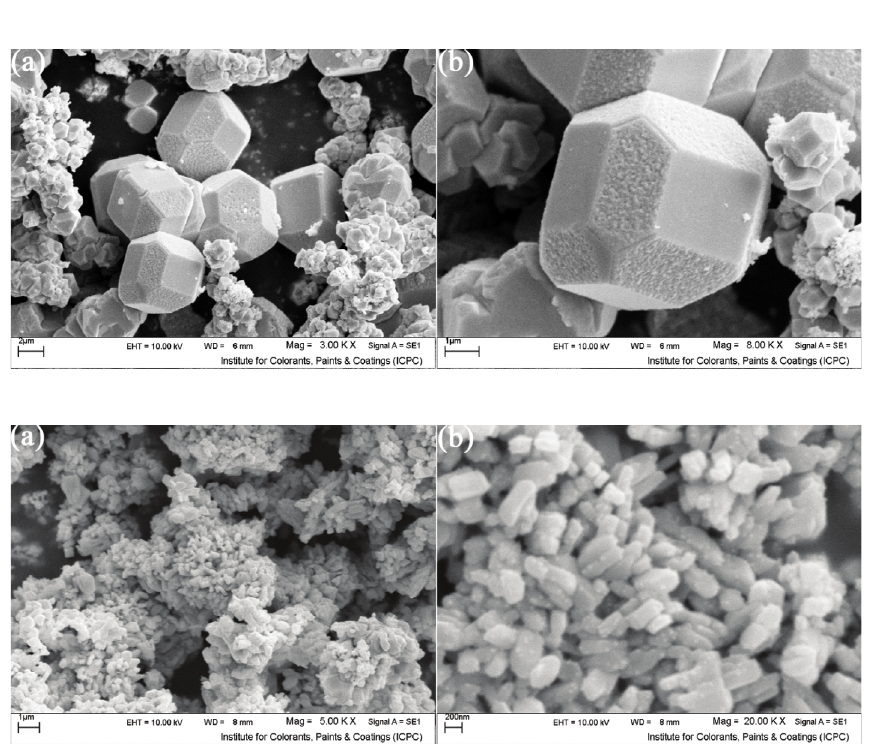
Figure 12 (a, b): SEM image of sample no. 4 with 10 KX and 20 KX magnification, respectively.